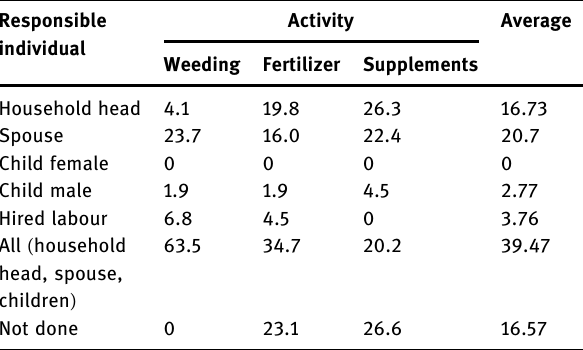
Table 8: Roles of men, women and youth in weeding and fertilizer application ( % of respondents